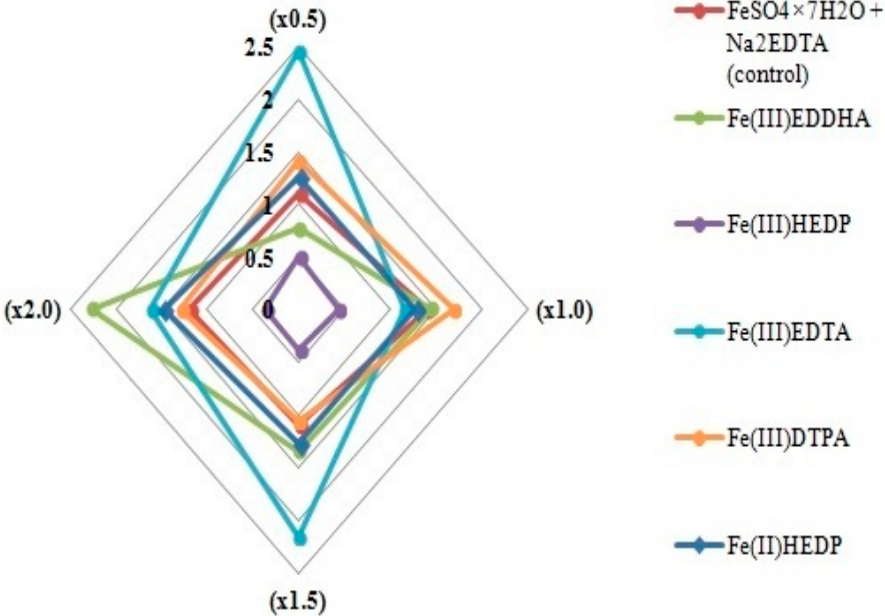
Figure 2. Average shoot length (cm) of blue honeysuckle “Lulia” ( Lonicera caerulea var. kamtschatica Sevast.) when applying different sources of iron in 4 concentrations: reduced ( × 0.5), standard ( × 1.0), increased ( × 1.5), and doubled ( × 2.0).